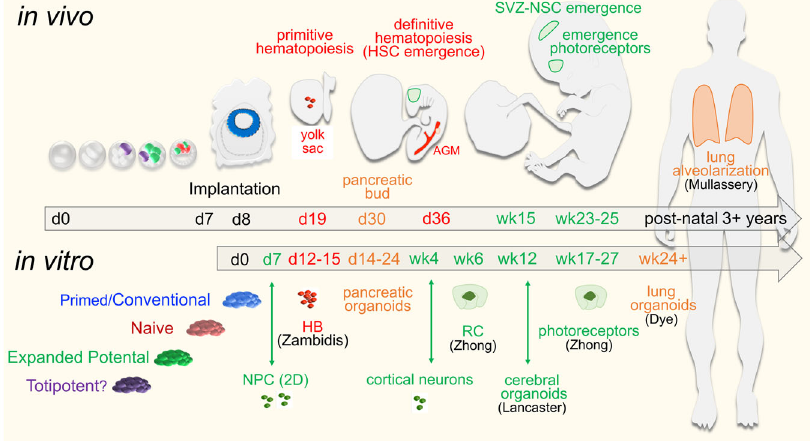
Fig. 2 Correlation of normal human developmental kinetics and its developmental congruence with in vitro hPSC directed differentiation. Mesoderm. The fi rst wave of human embryonic hematopoiesis begins in the yolk-sac at ~day 19 while self-renewing HSC emerges during the sixth week of gestation in the aorta-gonad-mesonephros (AGM) 123 . Embryonic hematopoietic waves arise from yolk-sac- like hemangioblast (HB) progenitors after 12 days of in vitro hematopoietic differentiation of hPSC 29,30 . Yolk sac-like hemogenic endothelium (HE) can similarly be derived via hPSC in vitro differentiation protocols after 15 days of hematopoietic differentiation 29,32 . Long-term engrafting HSCs similar to those arising from human fetal AGM have not yet been generated via in vitro hPSC differentiation. Endoderm. Pancreatic organoids can be generated in vitro from hPSC with early beta-islet and acinar progenitor cells between 14 and 24 days, and correlate with the emergence of the fetal pancreatic bud at ~day 30 51,52 . Lung alveolar structures generated in vitro from hPSC after 24 weeks of continuous culture resemble transcriptional phenotypes of fetal lung tissues 124,125 . Ectoderm retinal cup (RC) and photoreceptor differentiation can be recapitulated in vitro via hPSC-based retinal organoid protocols at ~6 and 17 weeks, respectively, and parallel in vivo retinal developmental events 63,126 . Post-natal adult neural stem cells emerge in utero in the sub-ventricular zone (SVZ) during week 15 of gestation, and their development can be recapitulated within cerebral organoids, albeit with limited progression to adult neural maturation 58,127